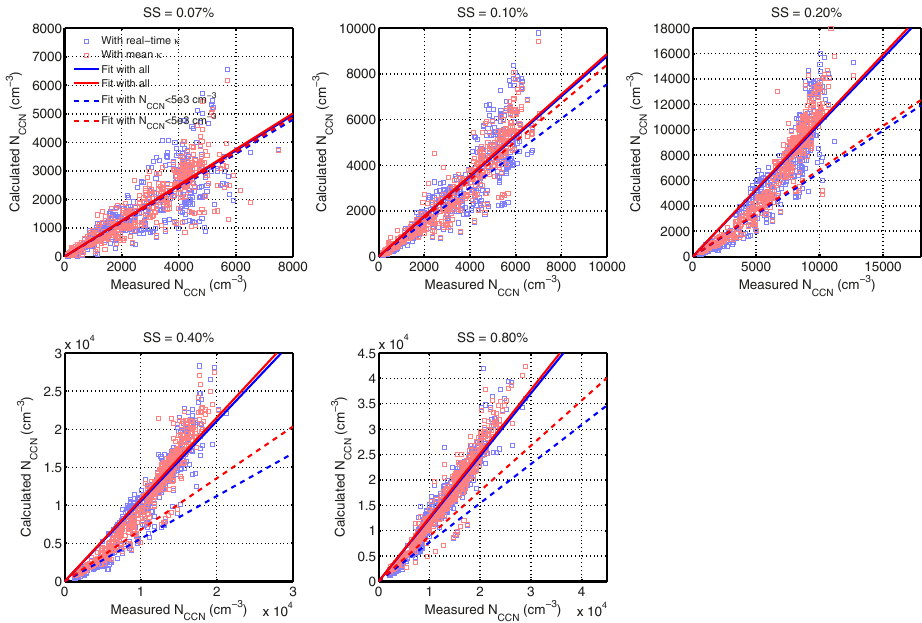
Figure 6. Comparison between in situ measured N CCN and calculated N CCN at five specific supersaturations. Blue squares represent the estimated N CCN with the real-time κ , while the red ones denote the estimation results with the overall mean κ during the entire f (RH) measurements. The blue and red solid lines stand for the fitting results of all the N CCN samples corresponding to the two kinds of κ , respectively; while the blue and red dashed lines are the fitting results in the case of measured N CCN <5000cm − 3